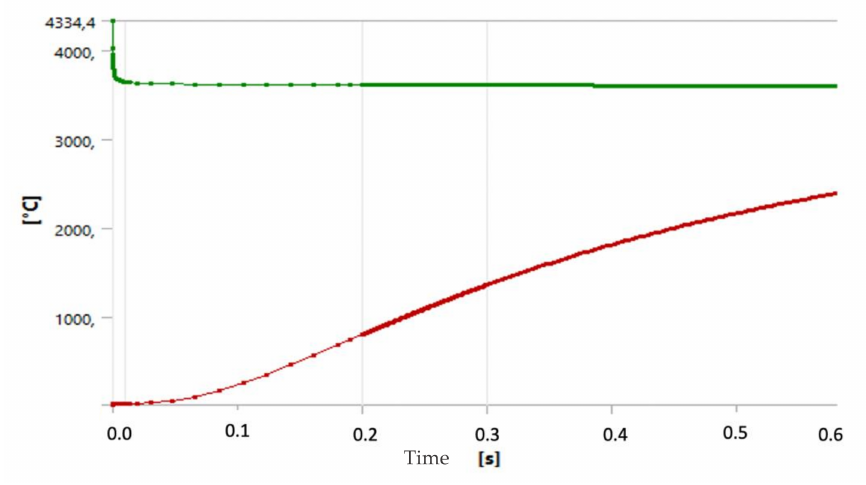
Figure 8. Temperature evolution for the middle of the joint and adjacent region fusion line +50 mm.